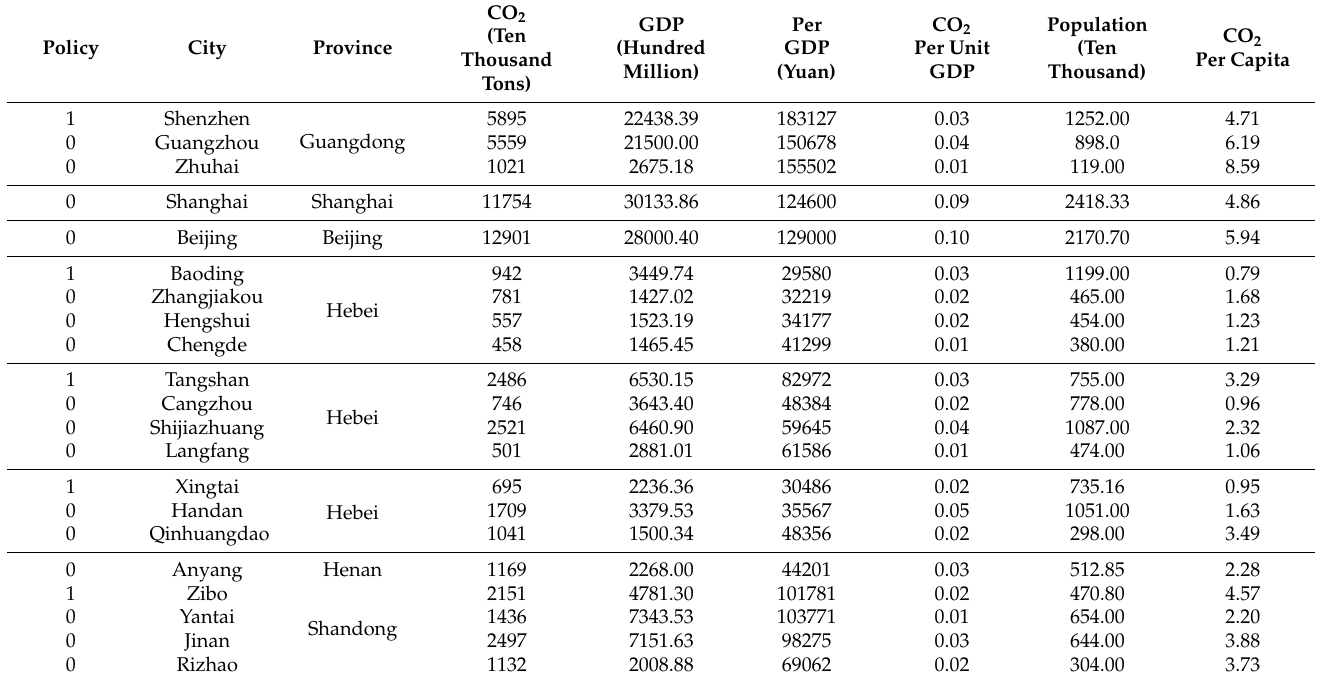
Table 1. Comparison of data for cities in the treatment and control